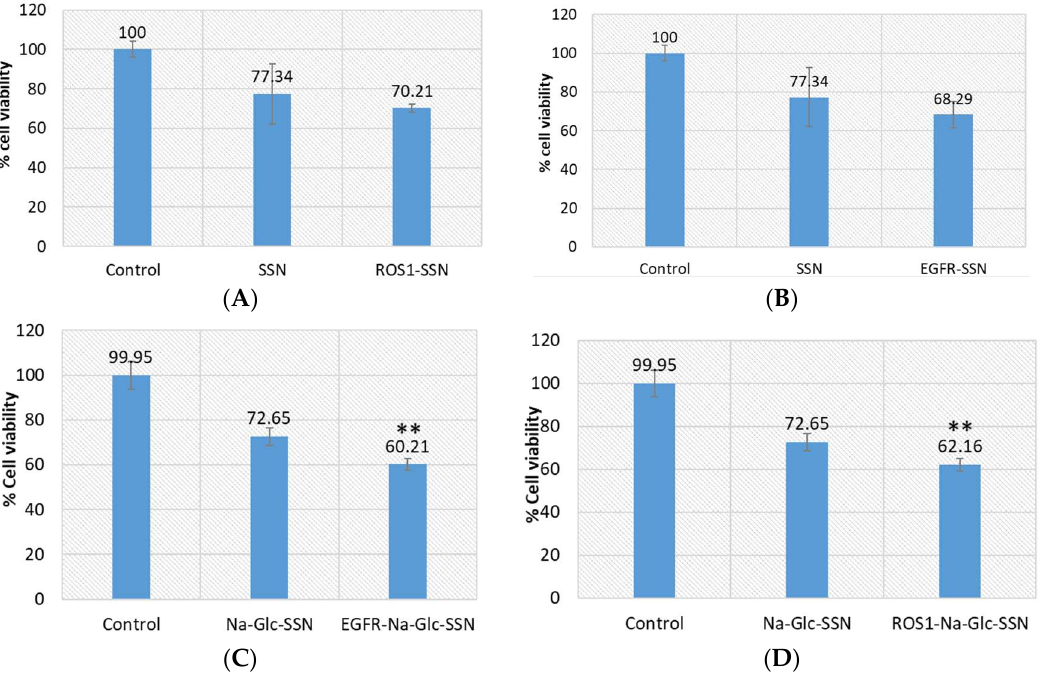
Figure 14. Cell viability assay following exposure of MCF-7 cells to SSNs and Na-Glc-SSNs with loaded ROS1 or EGFR siRNA. Cells were treated with particles alone and siRNA-loaded particles. SSNs and Na-Glc-SSNs were prepared by adding 60 mM SrCl 2 , without and with 300 mM of NaCl and 200 mm of D -glucose into 10 mM of Na 2 SO 3 . 1 nM of siRNA was used for fabrication of siRNA-loaded particles. Values are represented as % of cell viability in comparison to control for triplicate samples. ( A ). SSNs with loaded siRNA against ROS1. ( B ). SSNs with loaded siRNA against EGFR. ( C ). Na-Glc-SSNs with loaded siRNA against ROS1. ( D ). Na-Glc-SSNs with loaded siRNA against EGFR. Values were very significant (**) at p value 0.001 to 0.01 compared to NPs treatment.